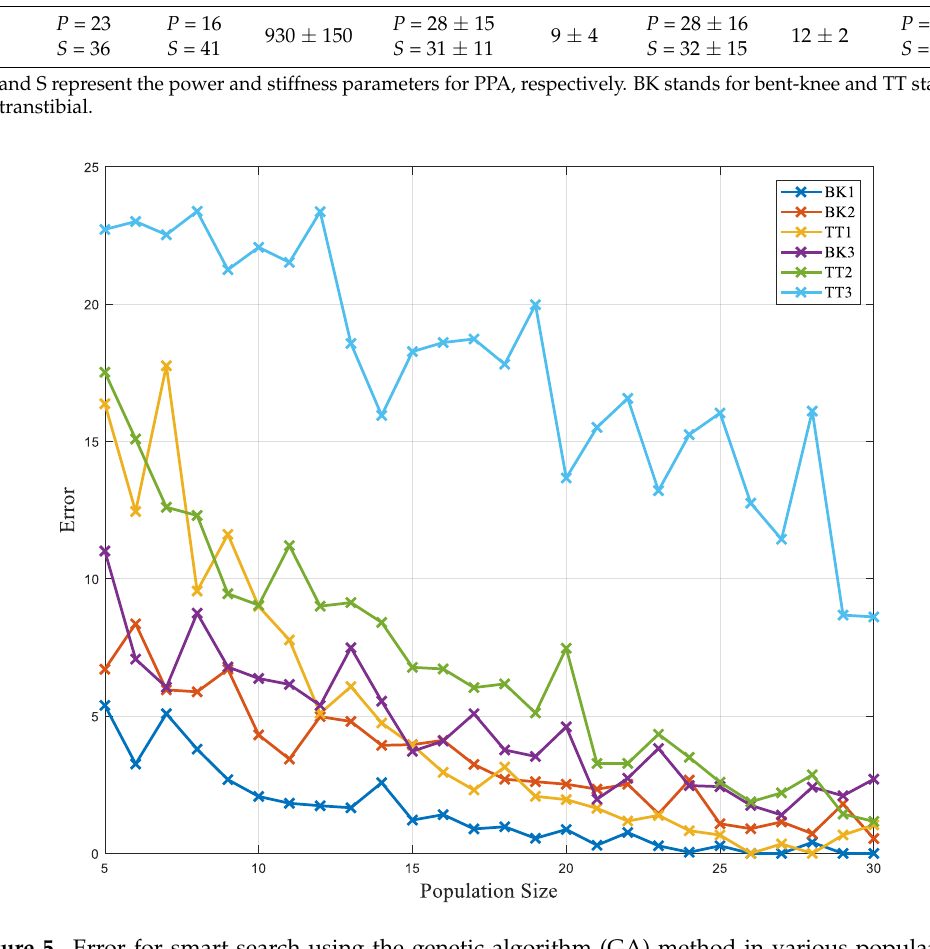
Figure 5. Error for smart search using the genetic algorithm (GA) method in various population sizes. The GA method was investigated using various initial population sizes to identify the smallest population size needed to converge to the global minima faster. The results are evaluated using an error measure, which is the distance of the result of the optimization from the target